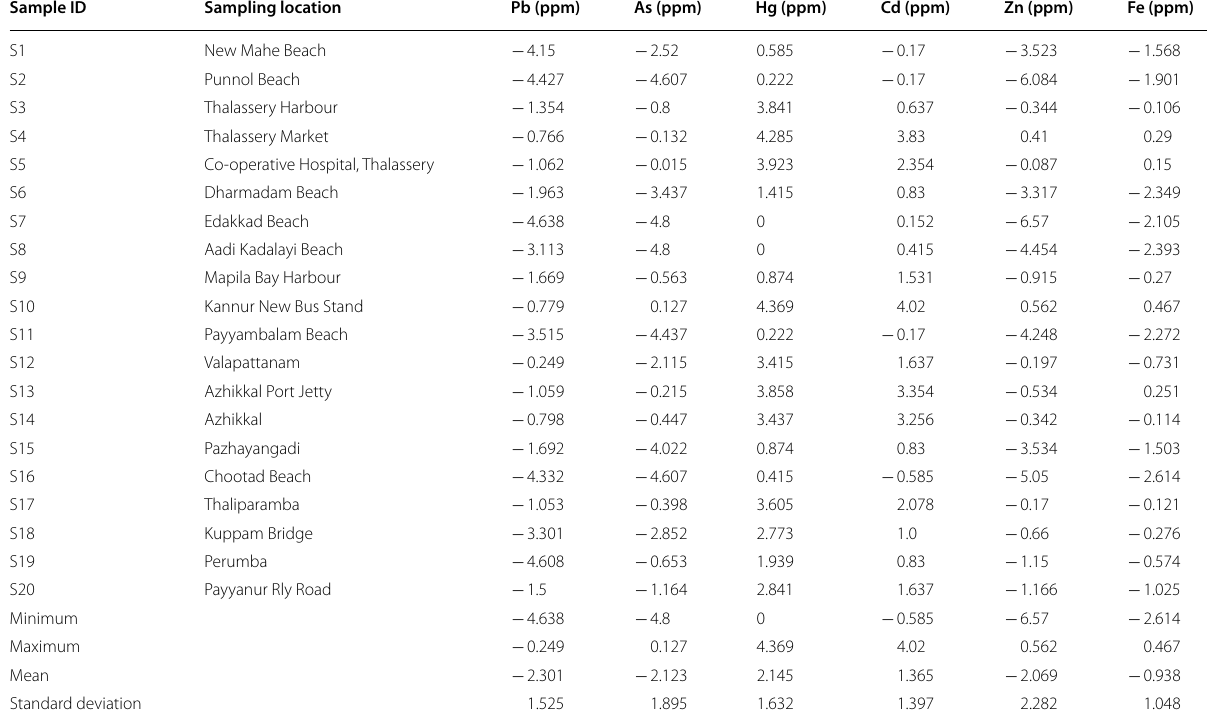
Sample ID Sampling location